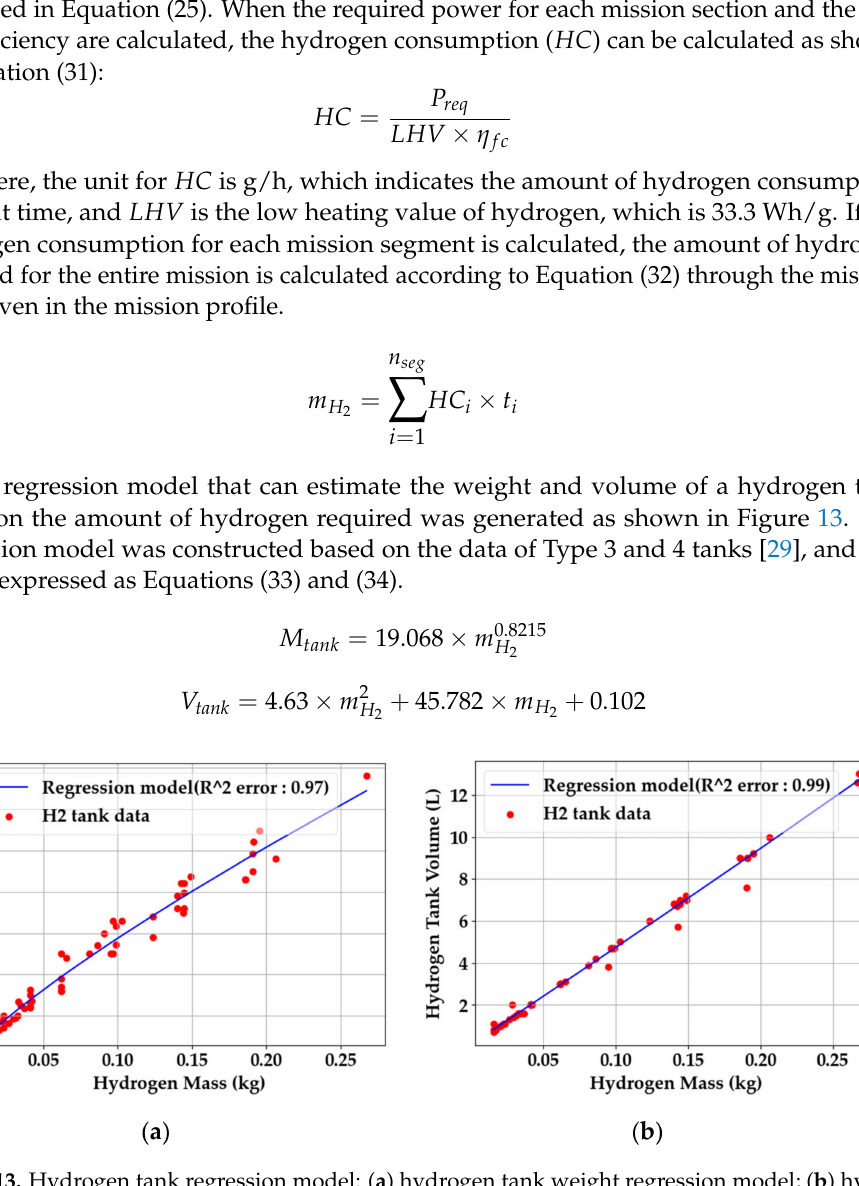
Figure 13. Hydrogen tank regression model: ( a ) hydrogen tank weight regression model; ( b ) hydro- gen tank volume regression. The accuracy of the model was measured by the R -squared error, and the accuracy was high at 0.97 and 0.99, respectively. The unit of mass for the hydrogen and the tank is in kg, and volume of the tank is in